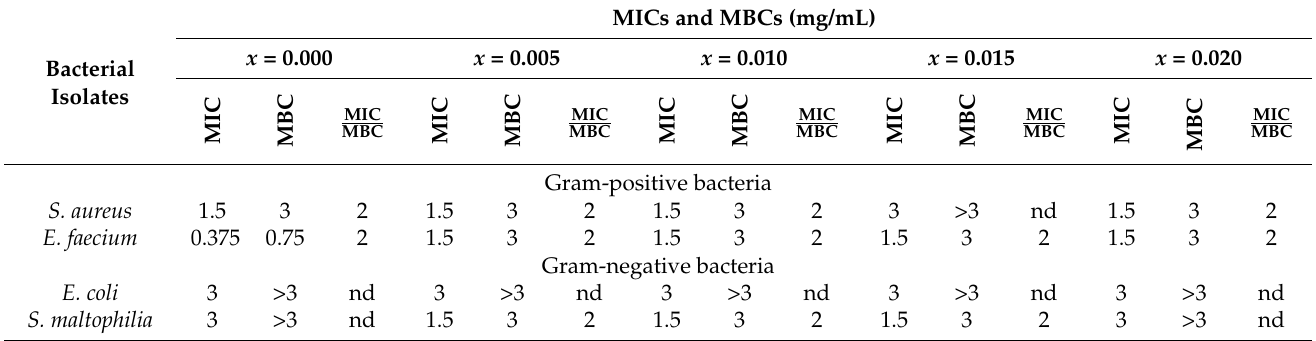
Table 2. MIC and MBC of the undoped and Mg-doped (Cu 1 −x Mg x O) NPs against four bacterial iso- lates.